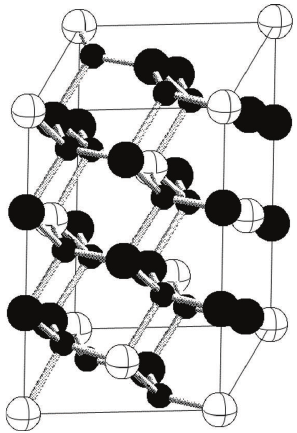
Figure 2: Monoclinic structure of Cu 2 SnS 3